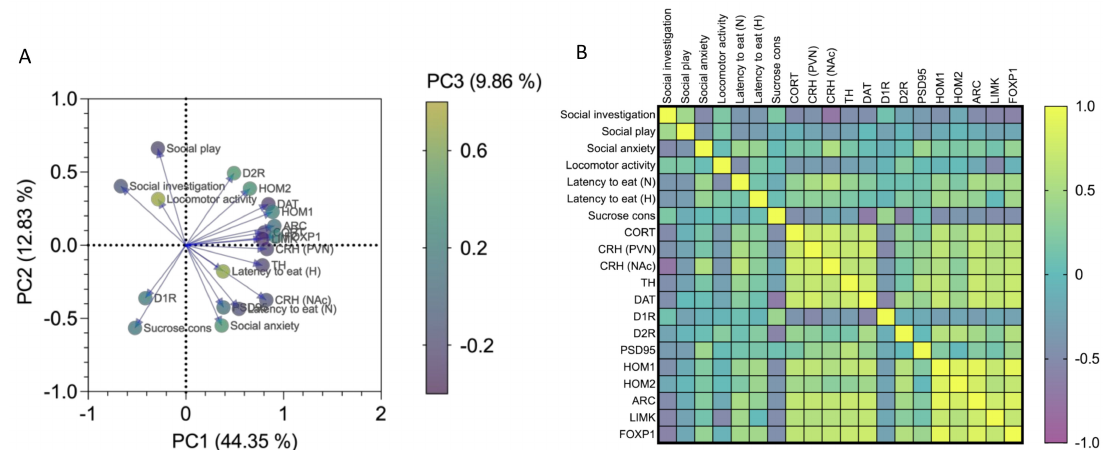
Figure 5. Affective and emotional behaviours in binge-like alcohol-exposed rats correlate with neuroendocrine stress response and transcriptional alterations in the NAc. ( A ) Loading-factor graph of principal component analysis shows how alterations of neuroendocrine stress response and protein expression at both presynaptic and postsynaptic levels in the NAc co-variate with affective end emotional behaviour observed in binge-like alcohol-exposed rats during adolescence. ( B ) The correlation matrix shows that altered affective and emotional behaviours correlate with neurobiological